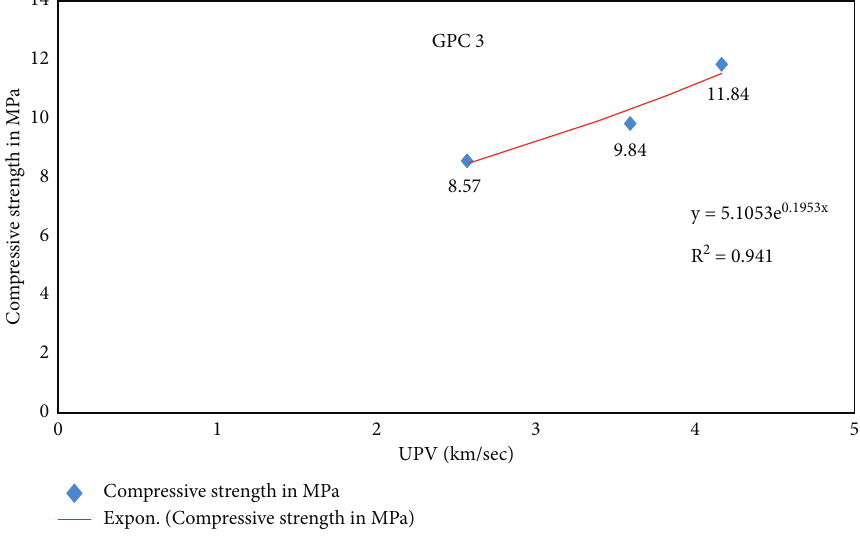
Figure 10: Relation between compressive strength and UPV for GPC 3.